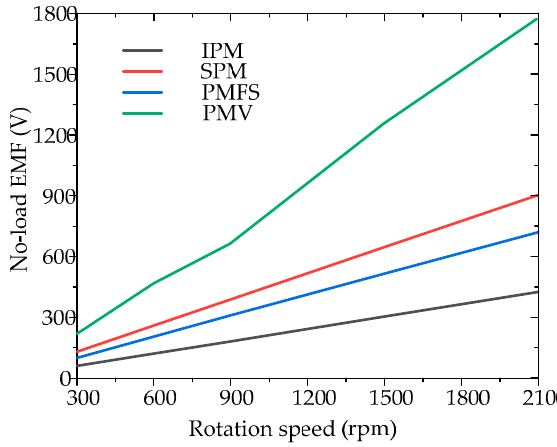
Figure 6. RMS of no-load EMFs of proposed six-phase outer-rotor PM machines under different speeds.